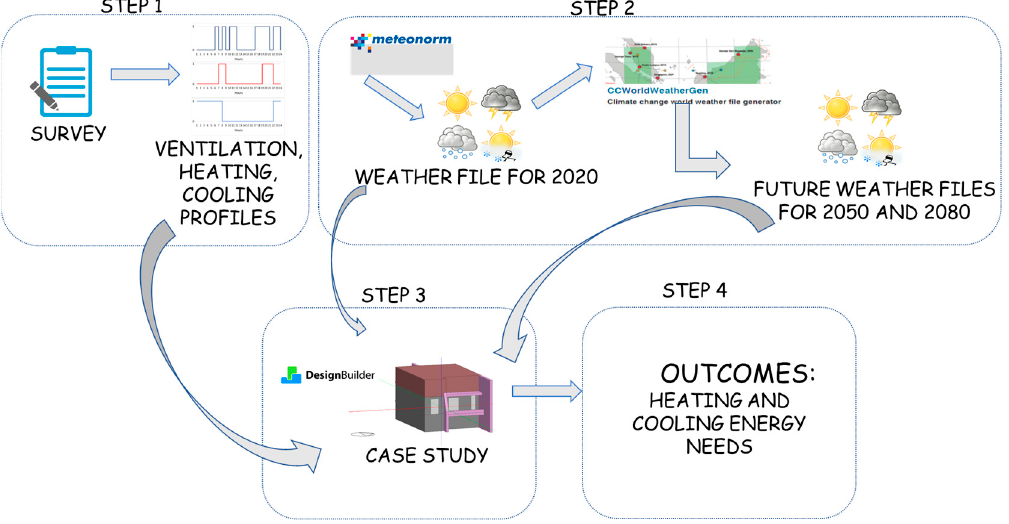
Figure 1. Schema of the adopted methodology.